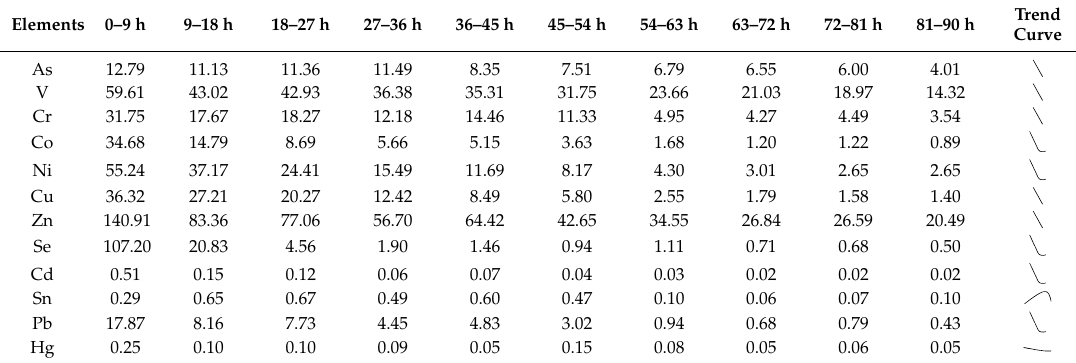
Table 7. Analytical concentrations of the selected trace elements in resulting leachates from 0–90 h in Experiment IV ( μ g/L).